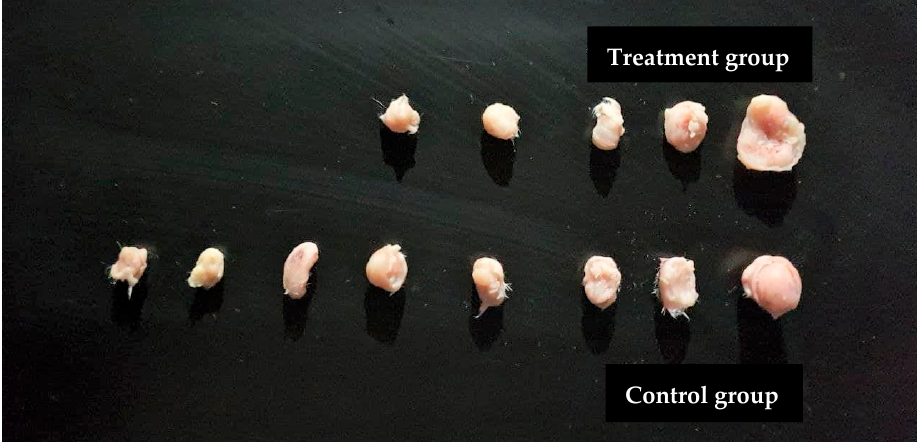
Figure 6. Comparison of tumor sizes after dissection at day 10 in both groups, n = 9 . Treatment of the mice with ethyl acetate extract of A. citrodora resulted in undetected and lower tumor sizes ( p = 0.003) compared to the control group.